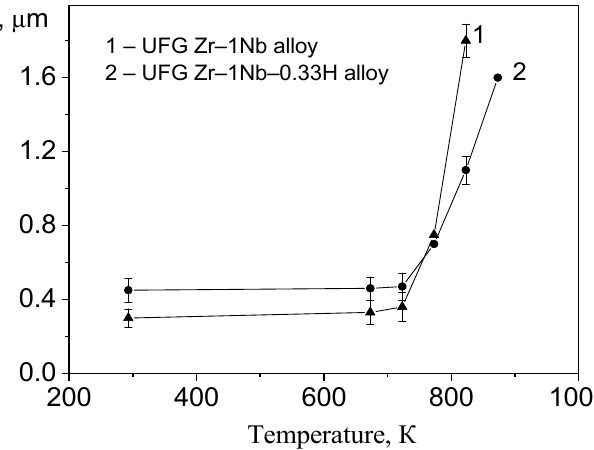
Figure 6. Temperature dependence of the change in the average grain size of the UFG structure of the zirconium